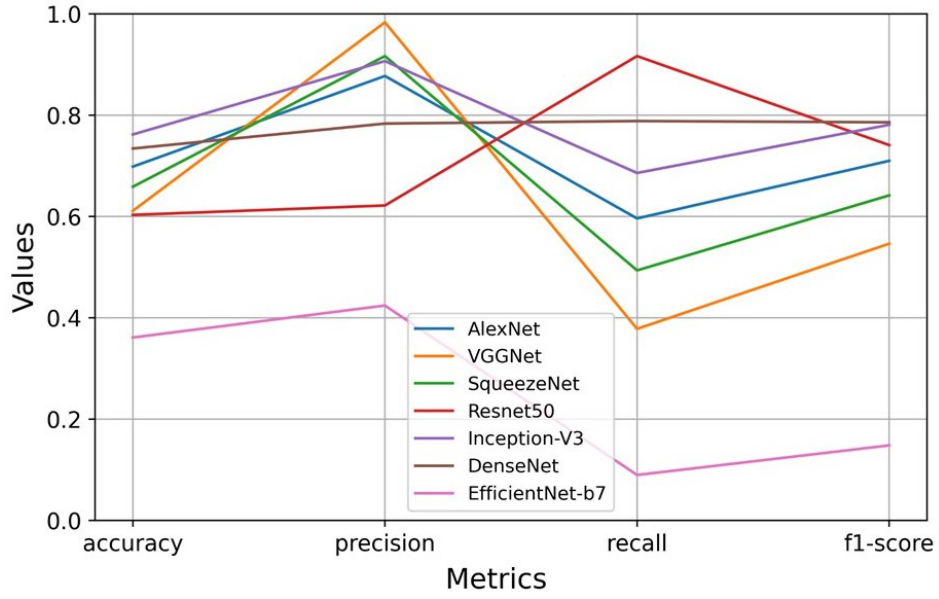
Figure 21. Evaluation of models on